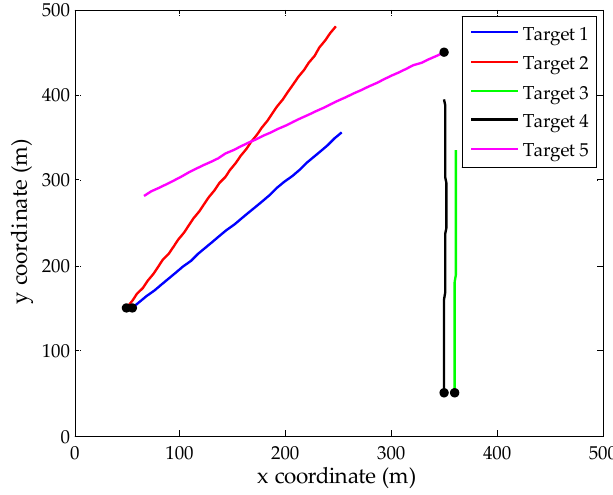
Figure 1. True target tracks in xy -plane, the start points for each track are denoted by •.